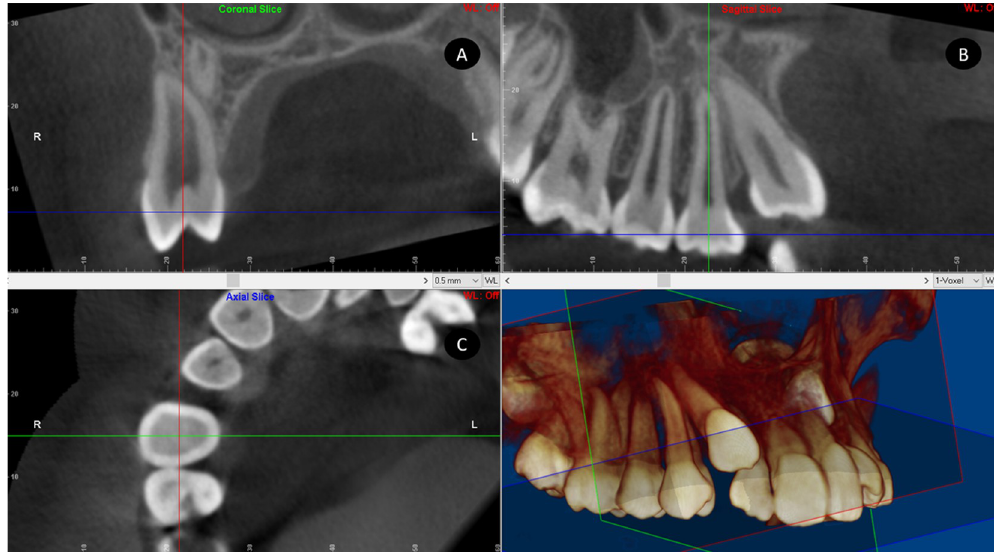
Fig 2. Location of PAMIC. A, coronal; B, sagittal; and C, axial